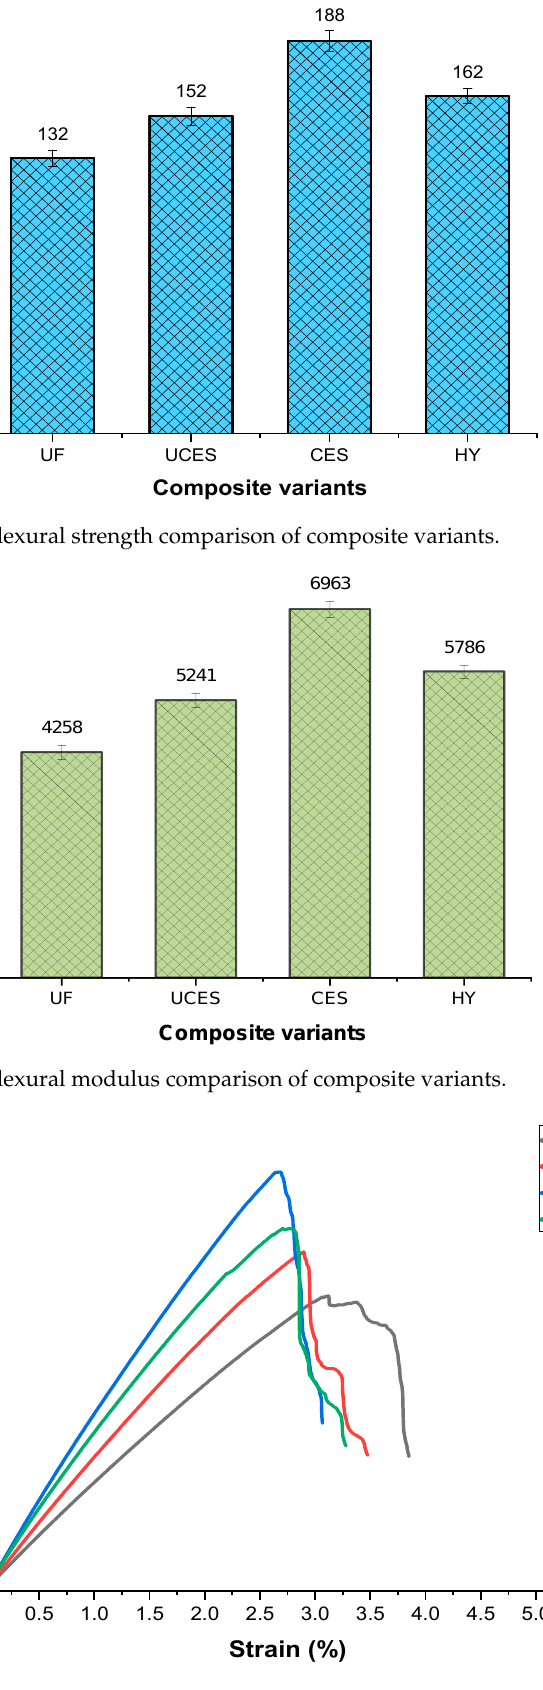
Figure 9. Stress–strain variation comparison of composite variants.